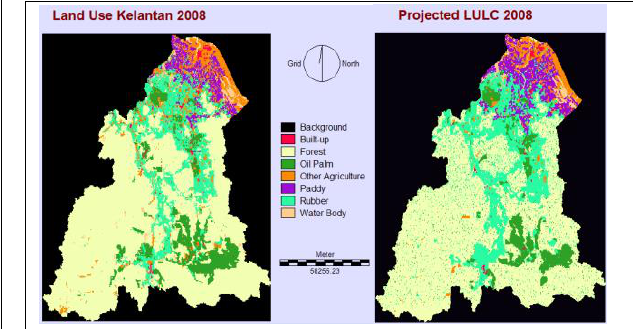
Figure 5. Projected LULC pattern 2008 and land use 2008.